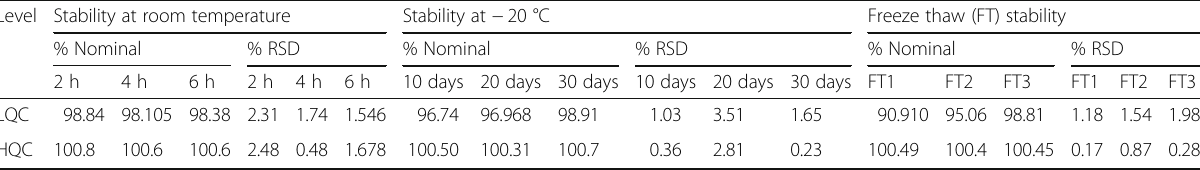
Table 6 Stability studies for chlorthalidone ( n = 5) Level Stability at room temperature Stability at − 20